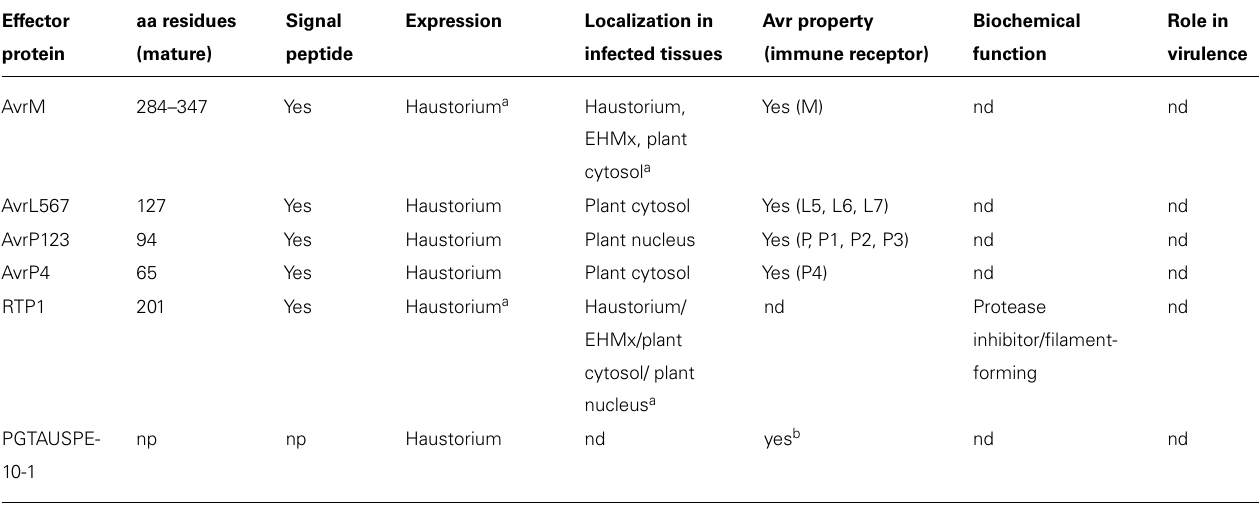
Table 1 | Rust effector